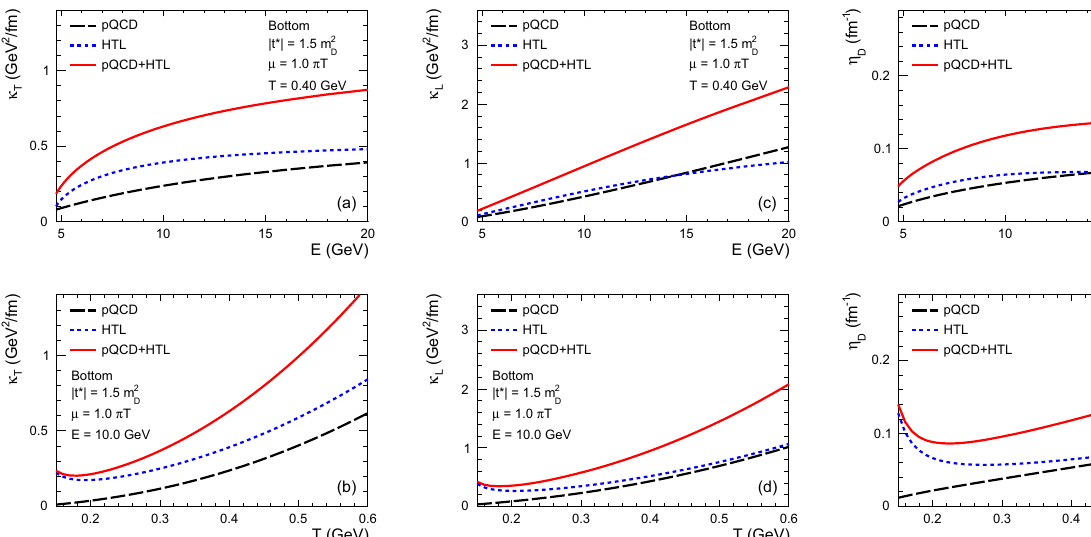
Fig. 4 Same as Fig. 3 but for bottom quark